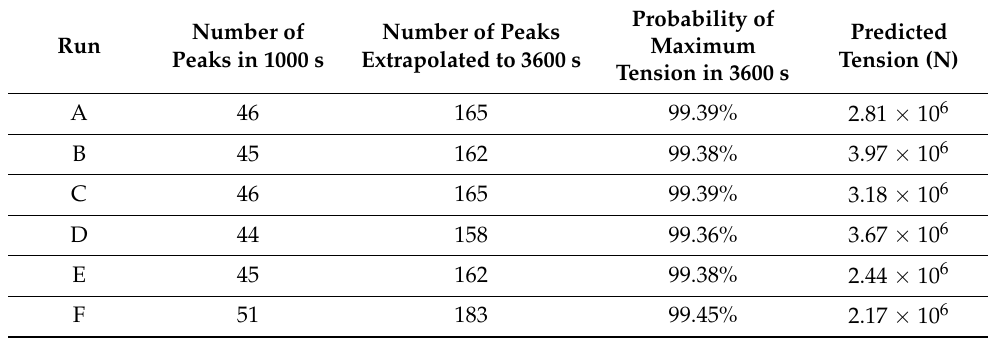
Table 7. Extrapolating the Maximum 1-Hour DLC 6.1 Line Tensions using 1000 s of Simulation